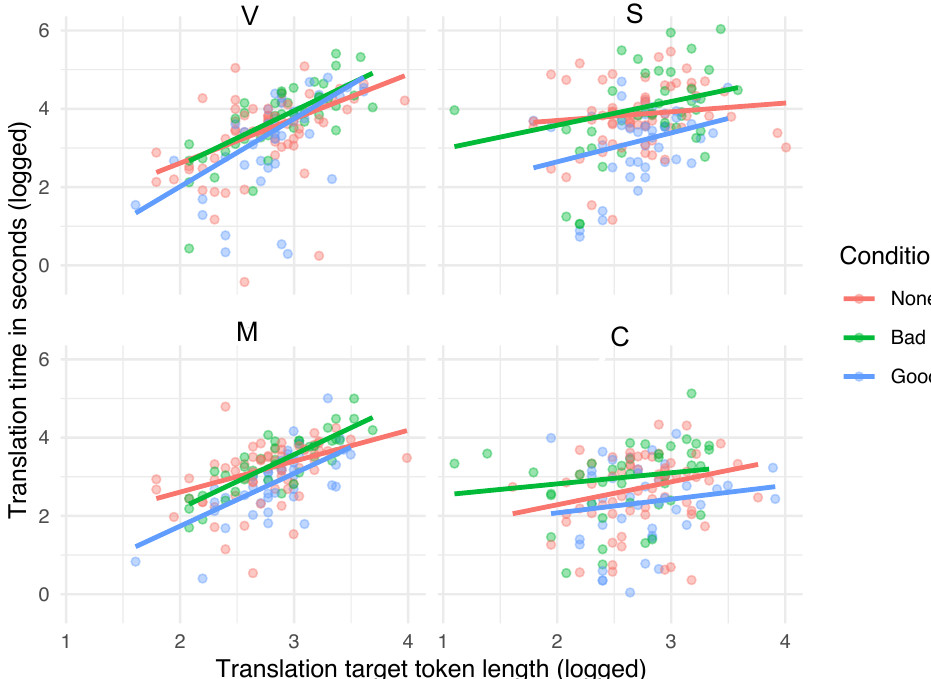
Figure 5. Summary of Post editing times by subject and condition (Good vs. Bad)—Raw